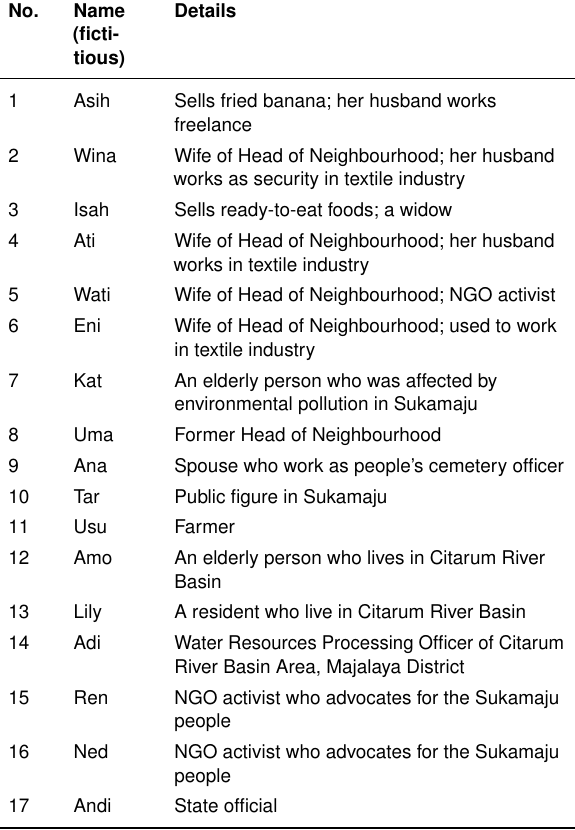
Table 1. List of